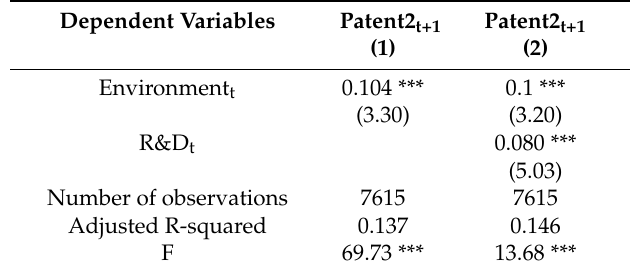
Table 10. Other patent